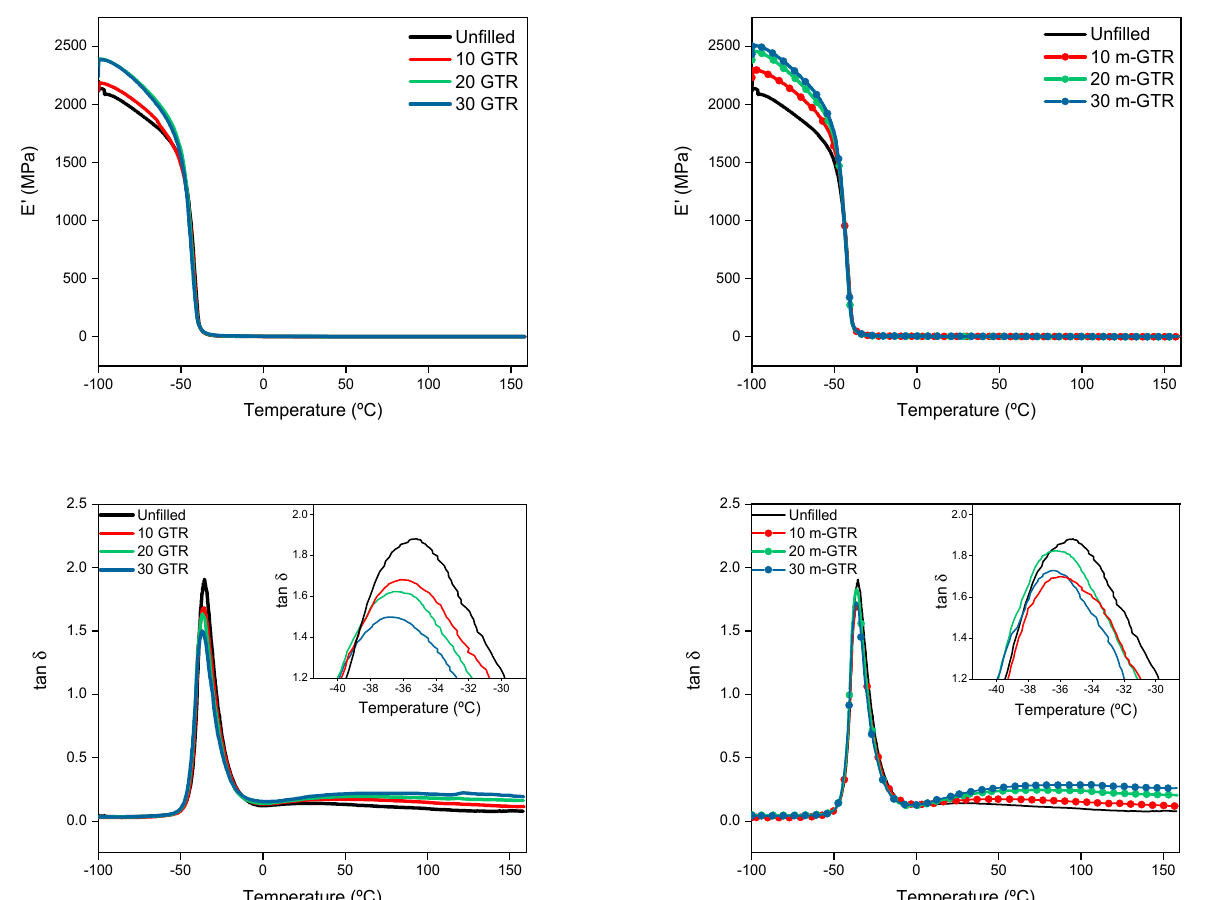
Figure 9. Storage modulus (E ʹ ) and loss tangent (tan δ ) of SBR-GTR and SBR-m-GTR composites.